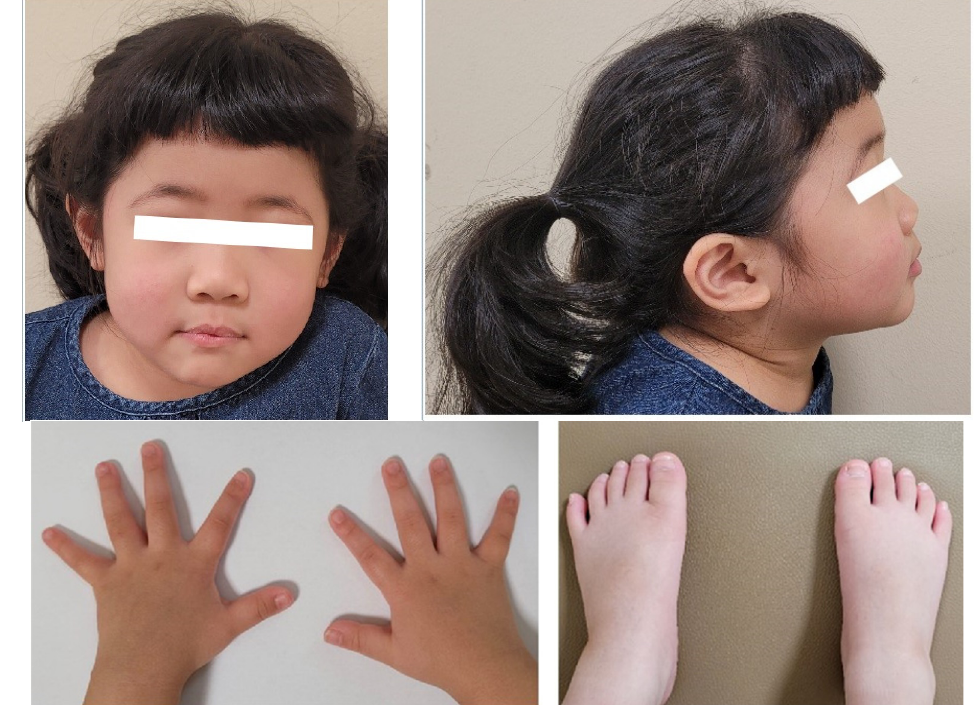
Figure 1. The patient's face, wide thumbs and great toes.